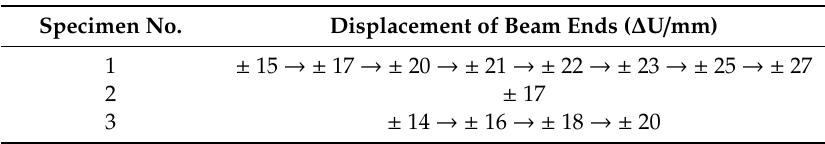
Table 4. Loading condition.